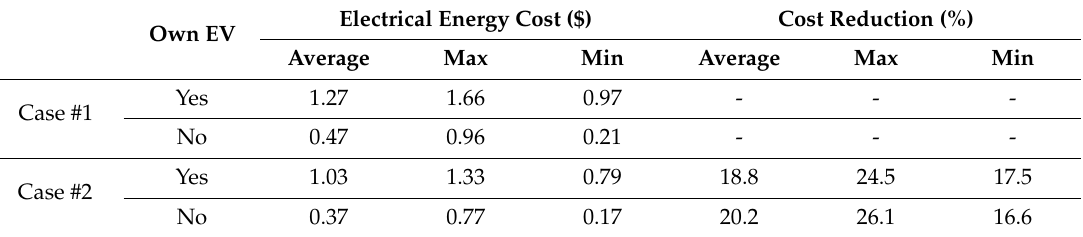
Table 5. The summary of the individual electrical energy